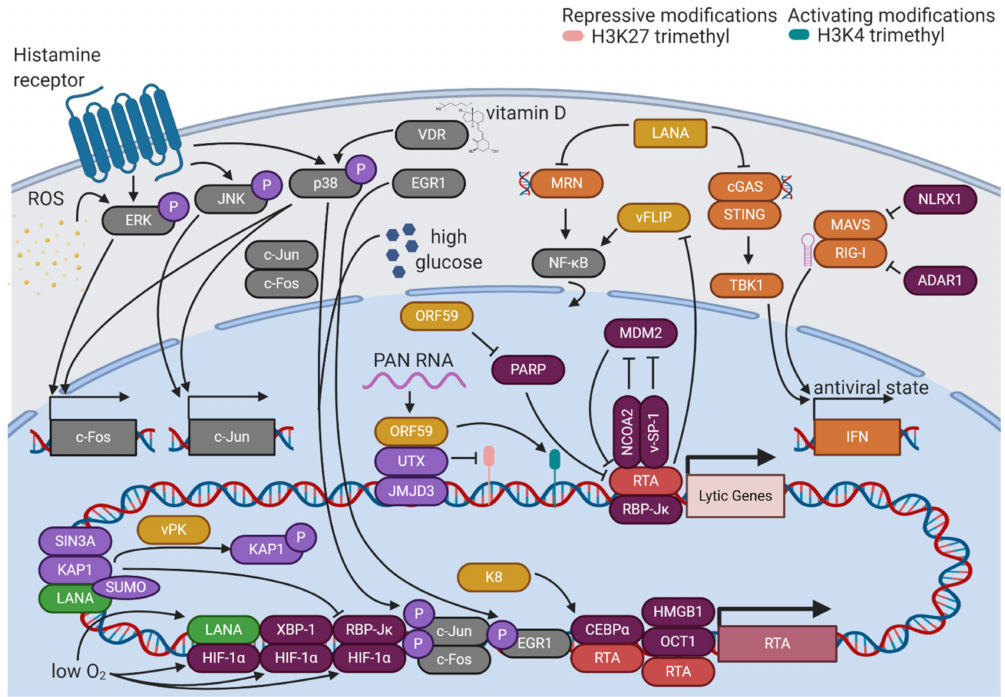
Figure 3. Environmental stimuli alter regulation of RTA to promote KSHV reactivation. Host signaling pathways integrate information about the cellular microenvironment that a ff ects the expression and activity of RTA. Lytic viral proteins promote KSHV reactivation in a feed-forward loop. Various isoforms and posttranslational modifications of LANA switch it from an organizer of latency to a facilitator of the lytic cycle. The cell-intrinsic immune system is antagonized by host and viral factors to augment viral